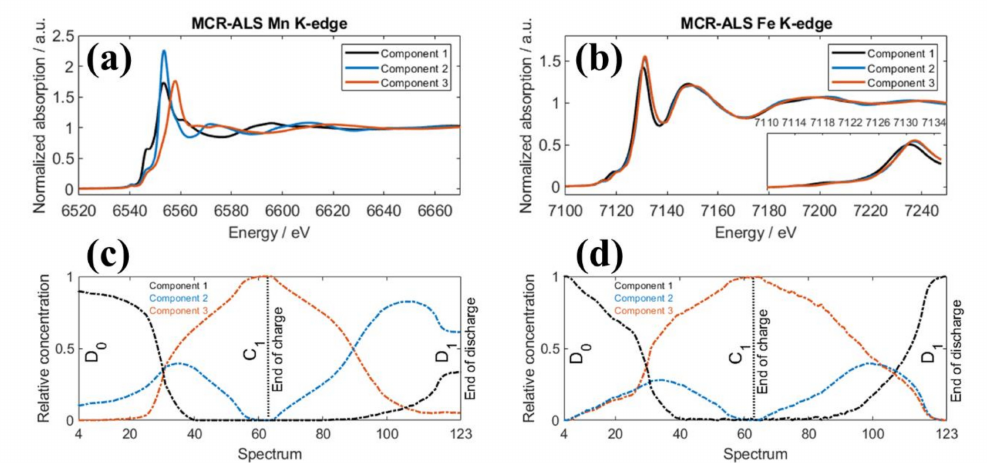
Figure 5. Multivariate Curve Resolution—Alternating Least Square (MCR-ALS) retrieved pure spectral components at the ( a ) Mn and ( b ) Fe K-edges and respective concentration profile plots ( c , d